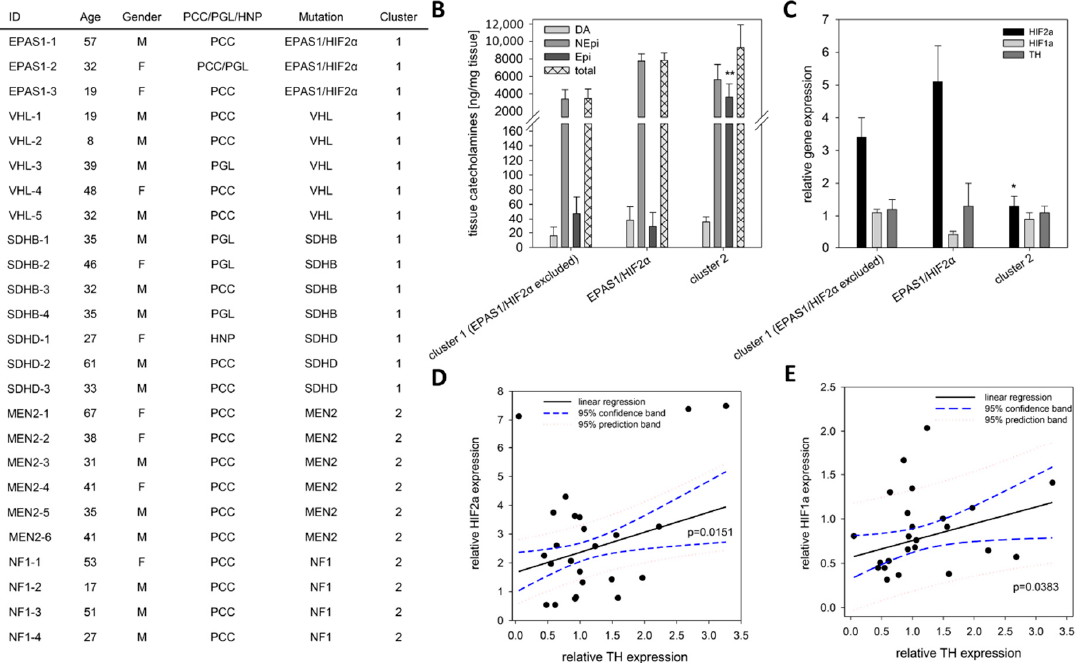
Figure 6. Expression pattern of EPAS1/HIF2 α , HIF1 α and TH in human tumor tissue. ( A ) Clinical characteristics of the included patients with confirmed mutation in well-described cluster 1 or cluster 2 related genes. ( B ) Tumor tissue from patients carrying a somatic gain-of-function mutation in EPAS1/HIF2 α ( n = 3) showed twice as much NEpi than other cluster 1 tumors that is also reflected by the total amount of catecholamines (sum of DA, NEpi and Epi). An elevated content of Epi was observed for mature cluster 2 tumors in comparison to the immature cluster 1 tumors. Mean ± SEM. ANOVA and Bonferroni post hoc test comparison vs. cluster 1 and EPAS1/HIF2 α , ** p < 0.01. ( C ) qRT-PCR analysis showed an elevated EPAS1/HIF2 α expression in cluster 1 PPGLs; whereas the TH expression remains unaffected by the underlying mutations in the different cluster. Mean ± SEM. ANOVA and Bonferroni post hoc test comparison vs. cluster 1 and EPAS1/HIF2 α , * p < 0.05. ( D ) A significant linear correlation between the expression of EPAS1/HIF2 α and TH could be detected (f = 1.667 + 0.681x, r = 0.490, R 2 = 0.2399). ( E ) A similar correlation was also observed for the expression of HIF1 α and TH (f = 0.566 + 0.190x, r = 0.4252, R 2 = 0.1808).